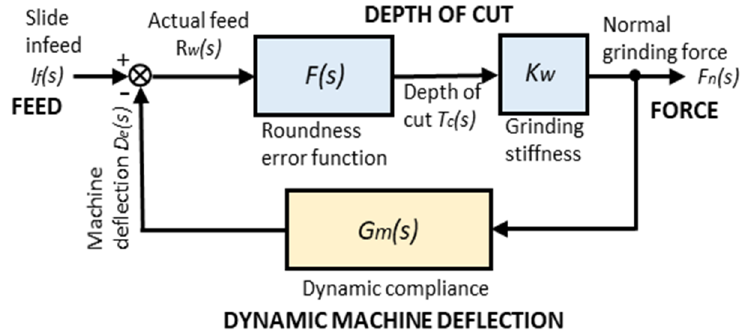
Figure 2. Dynamic grinding model for roundness stability criterion.